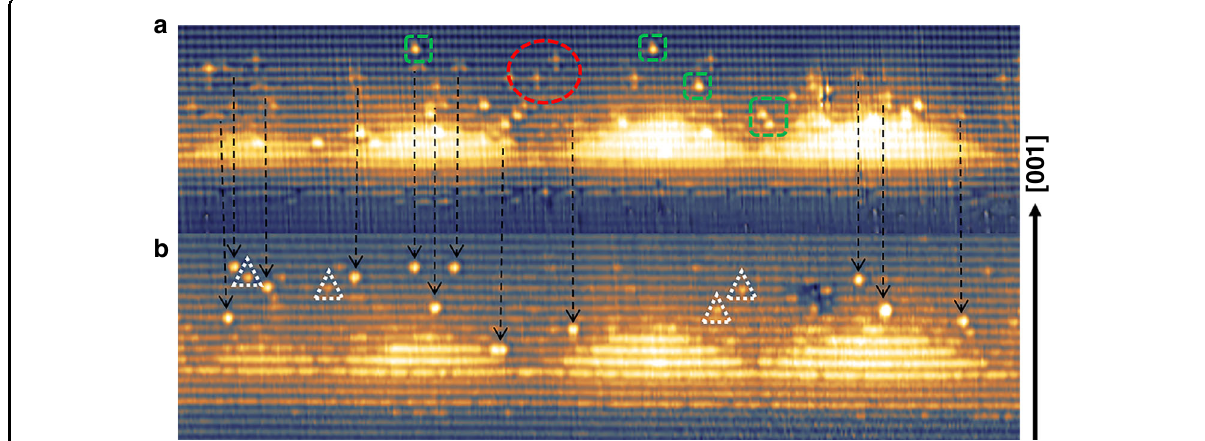
Fig. 8 40 × 11 nm2 X-STM images of the same area. a Empty-state image taken at Vb = + 3.0 V, It = 90 pA. b Filled-state image taken at Vb = − 3.65 V, It = 90 pA. The black arrows indicate the position of Sb atoms in both images, the white triangles indicate some of the subsurface Sb atoms in the fi lled-state image, the green squares indicate some of the segregated surface In atoms, and the red circle indicates some subsurface In atoms. The dark to bright contrast difference is 250 pm and the arrow on the right side indicates the growth direction